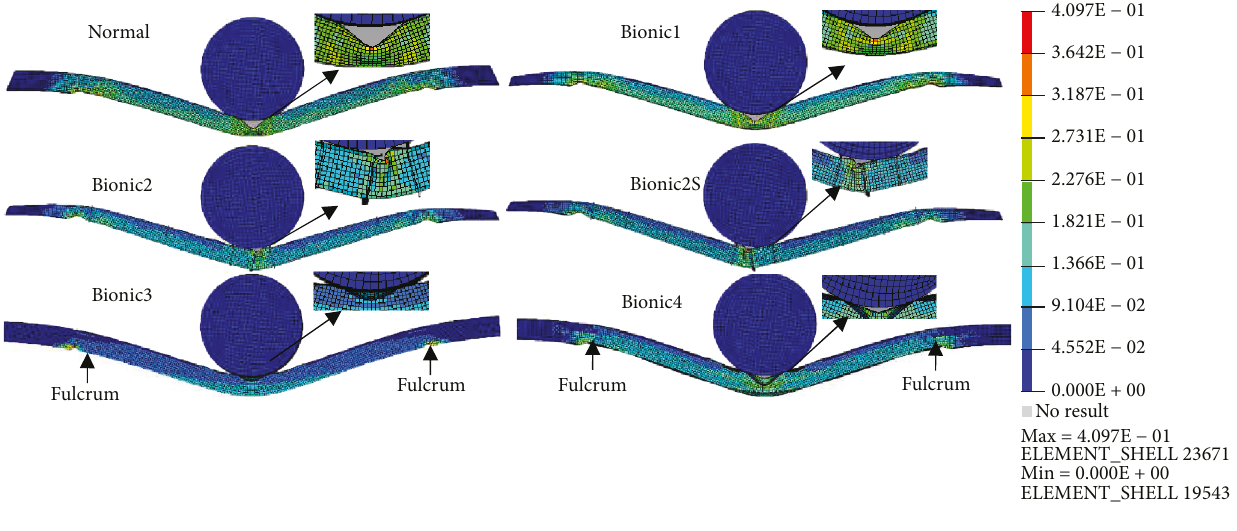
Figure 14: The deformation, enlarged partial view, and von Mises of the bumper ’ s pole impact. Table 4: The impact performance parameters of the